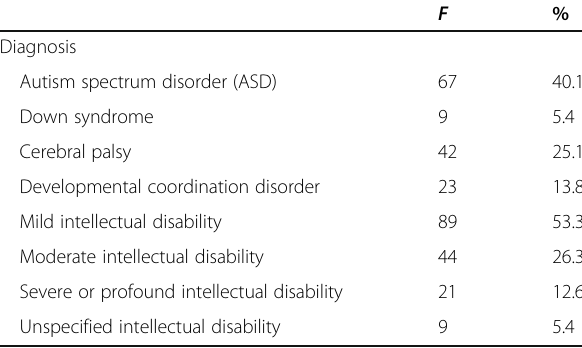
Table 1 Distribution according to the diagnoses reported by the clinical sample